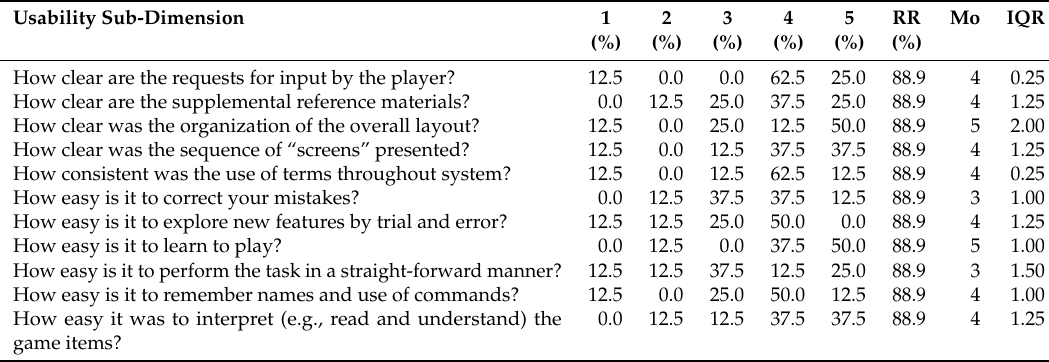
Table A9. MARISA Game